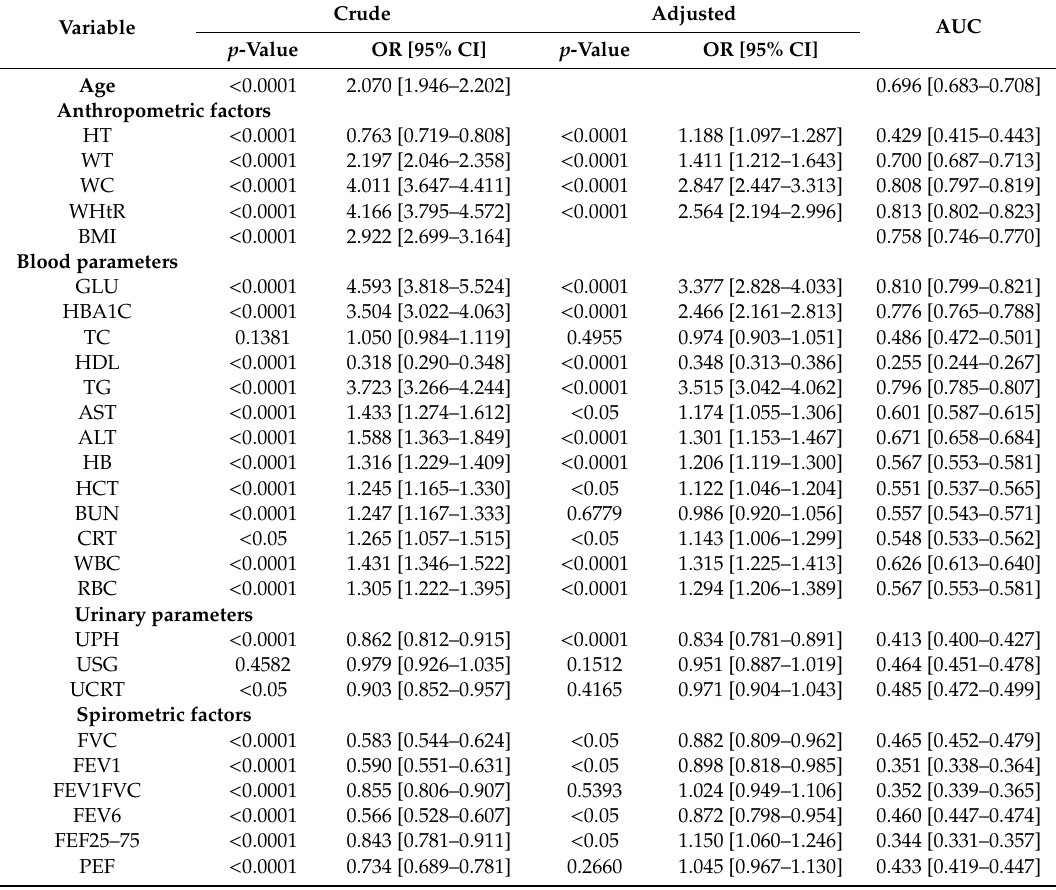
Table 4. Associations of anthropometric factors, blood parameters, urinary parameters, and spirometric factors with metabolic syndrome in